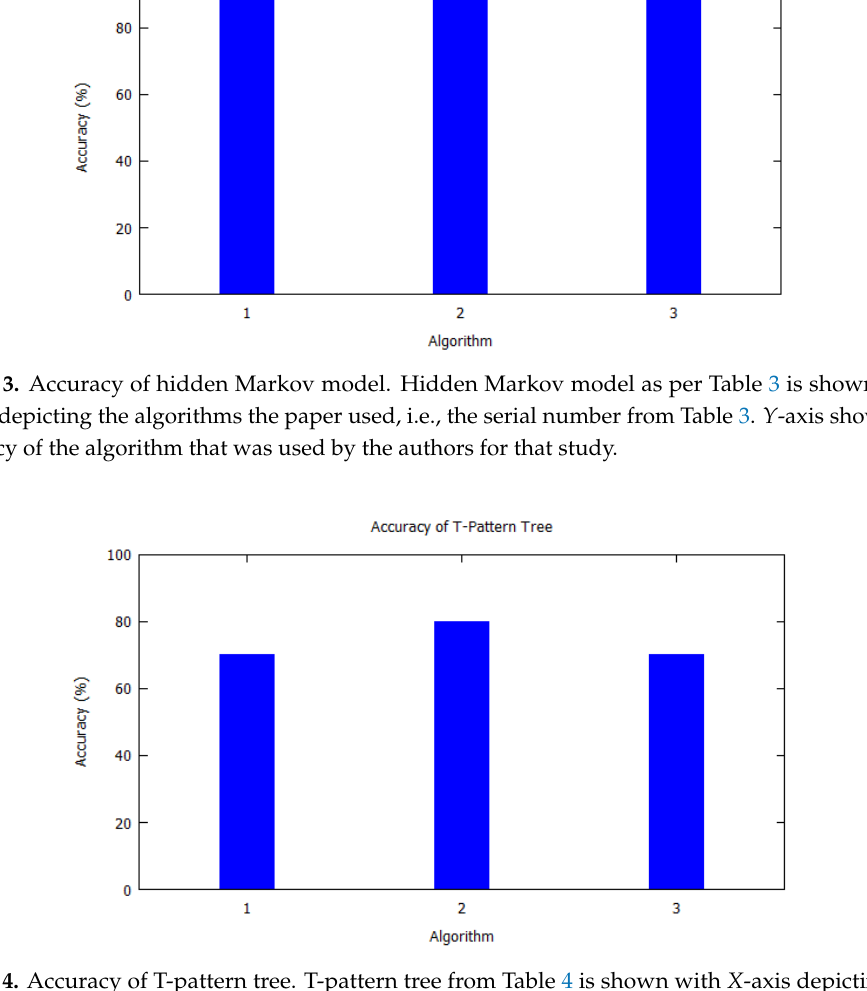
Figure 4. Accuracy of T-pattern tree. T-pattern tree from Table 4 is shown with X -axis depicting the algorithms the paper used, i.e., the serial number from Table 4. Y -axis shows the accuracy of the algorithm that was used by the authors for that